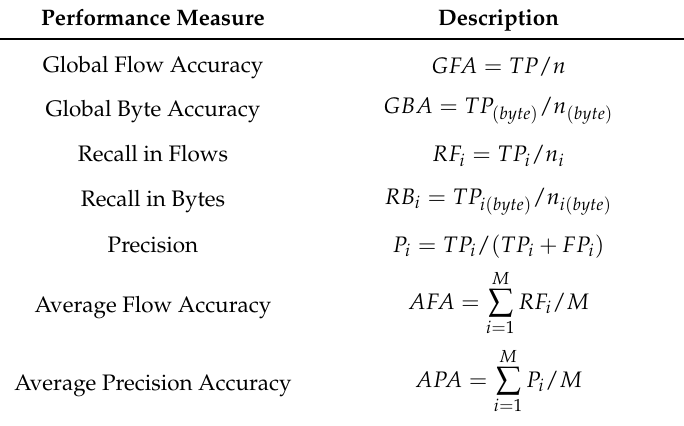
Table 2. The performance measures used during the